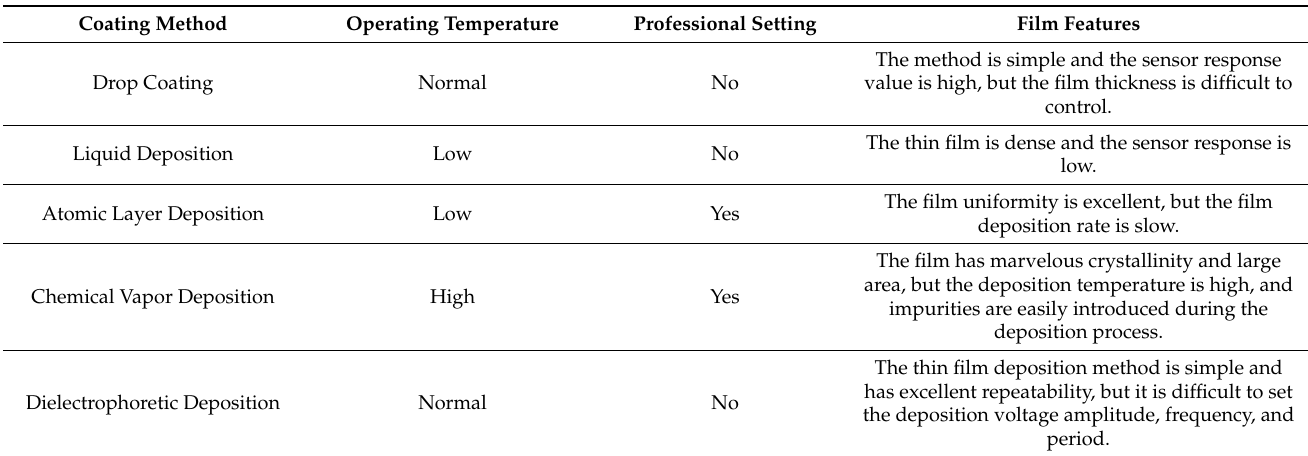
Table 3. Comparison of thin film coating